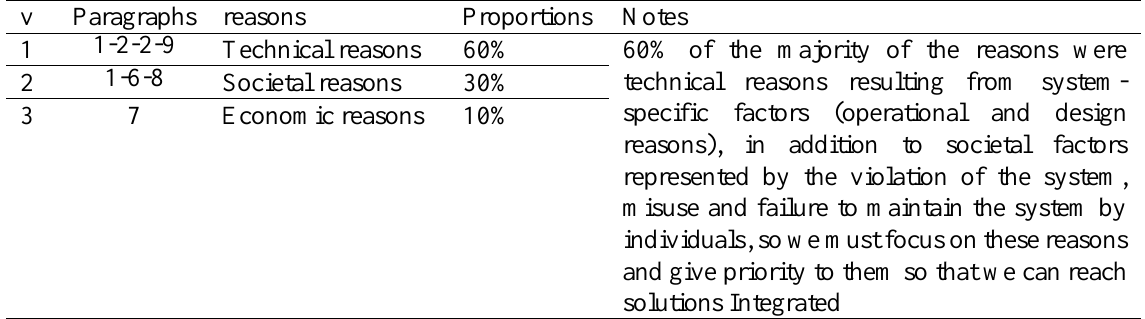
Table 6. The most important causes of drinking water delivery service problems / Source: The researcher based on the above